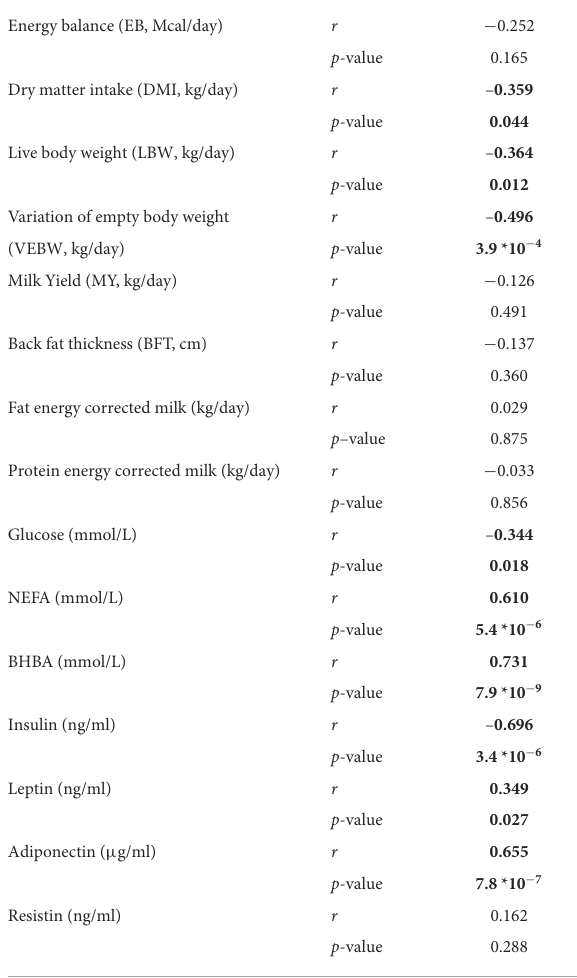
TABLE 6 Spearman correlation coefficients (r) between FNDC5 plasma concentration and zootechnical parameters and plasma metabolites and hormones in both LNEB and HNEB animals during the peripartum period (4WAP − 16WPP). Parameter Plasma